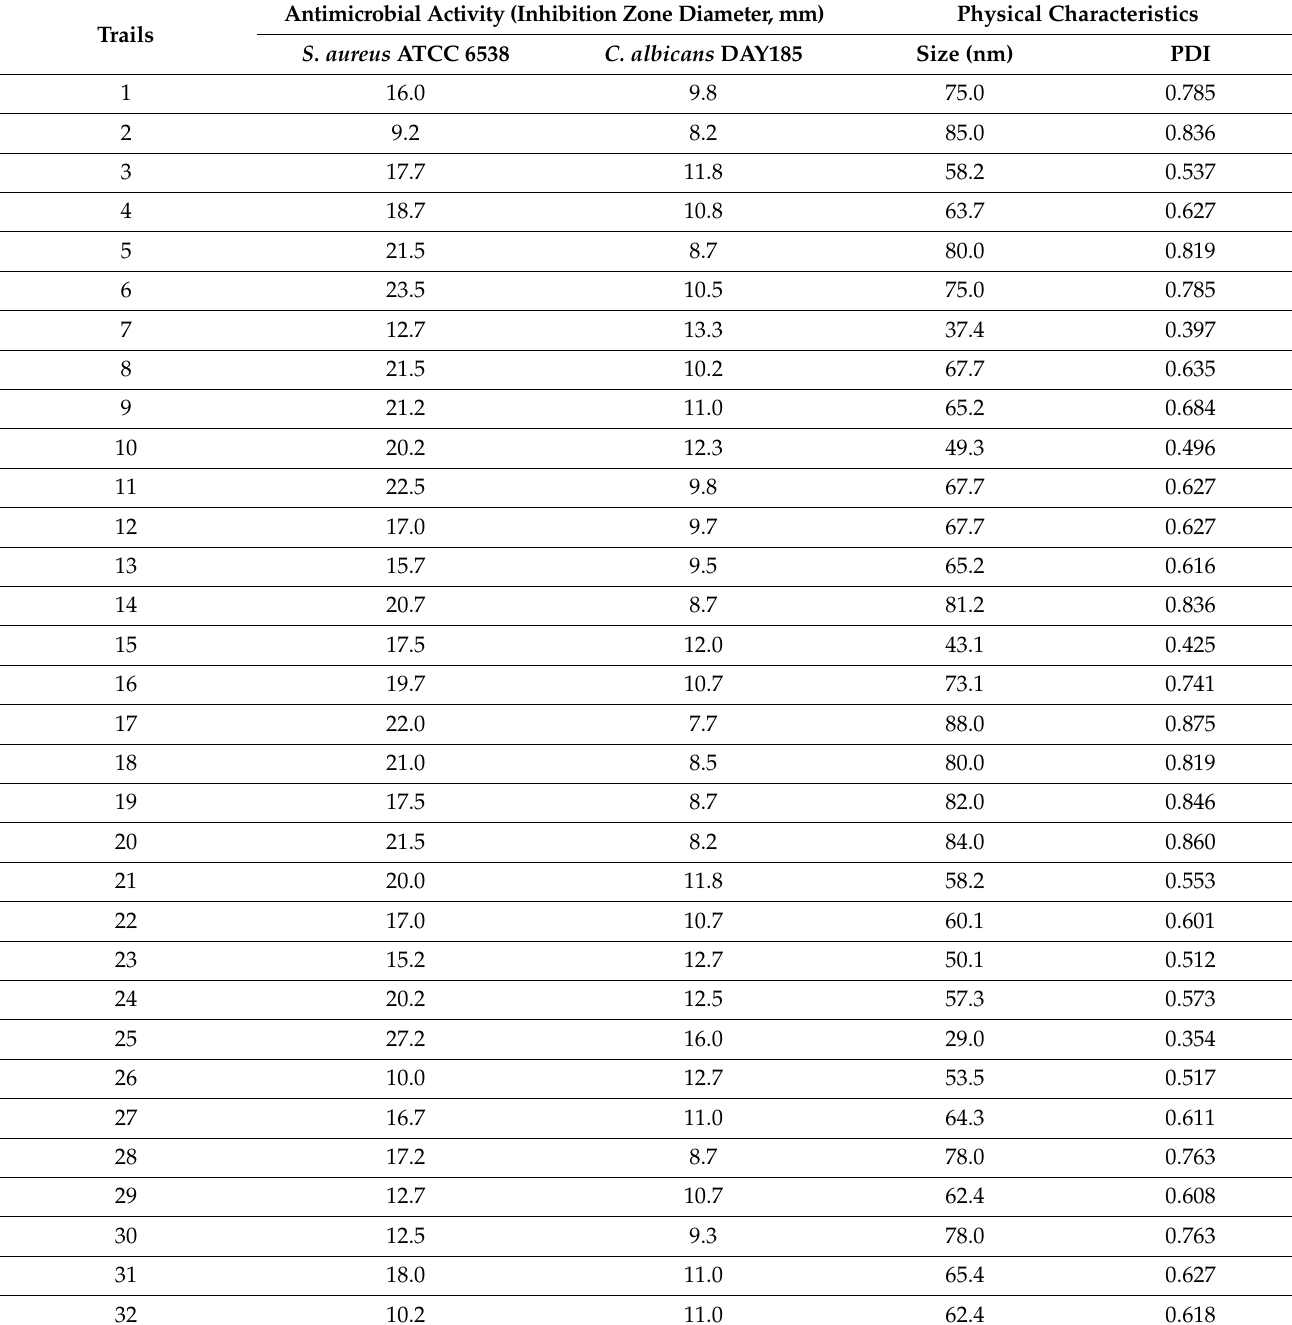
Table 3. Mo-capped AgNP synthesis optimization using multilevel factorial